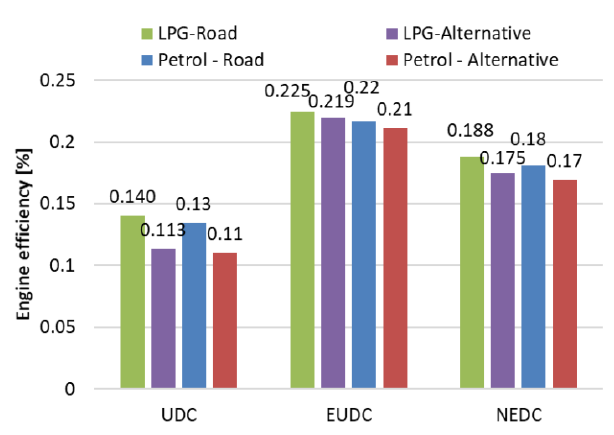
Fig. 18. Impact of resistance forces on average engine